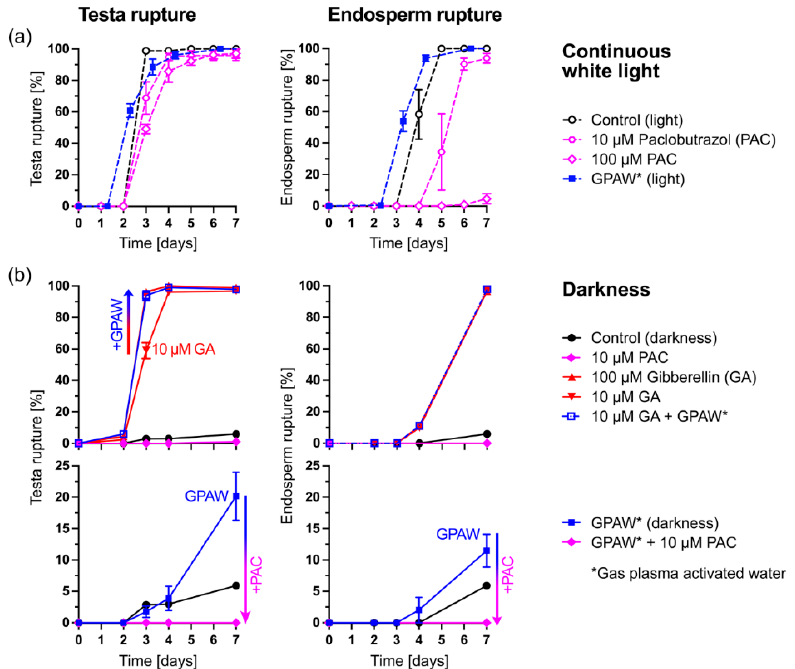
Figure 2. The effects of gas-plasma-activated water (Air GPAW) and GA biosynthesis inhibition on the time courses of Nicotiana tabacum testa rupture (TR) and endosperm rupture (ER). ( a ) Effect of